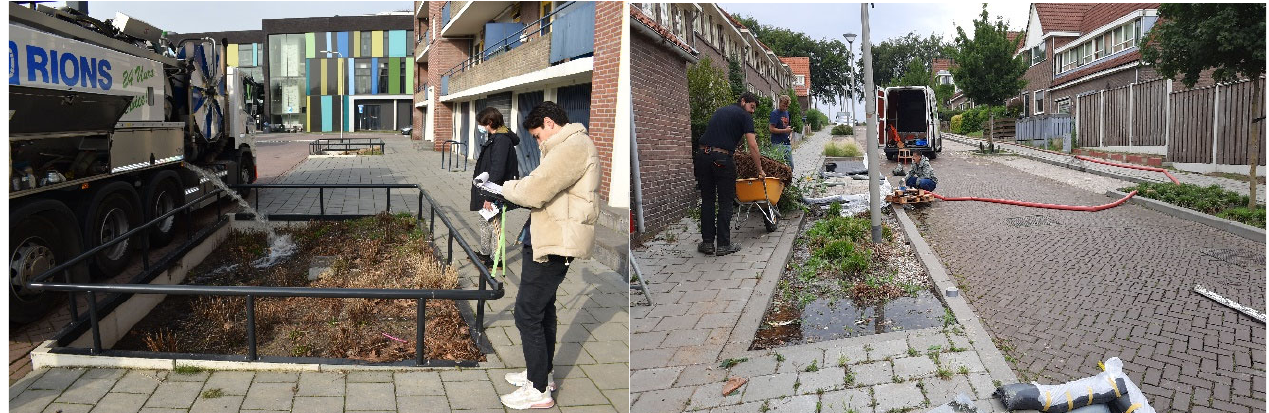
Figure 13. Measurements at two streets with multiple green infrastructure in The Netherlands: Azuurweg Tilburg ( left , ClimateScan. Available online: https://www.climatescan.nl/projects/6052/detail (accessed on 1 January 2022)) and Reestraat Arnhem ( right , ClimateScan. Available online: https://www.climatescan.nl/projects/1109/detail (accessed on 1 January 2022)).